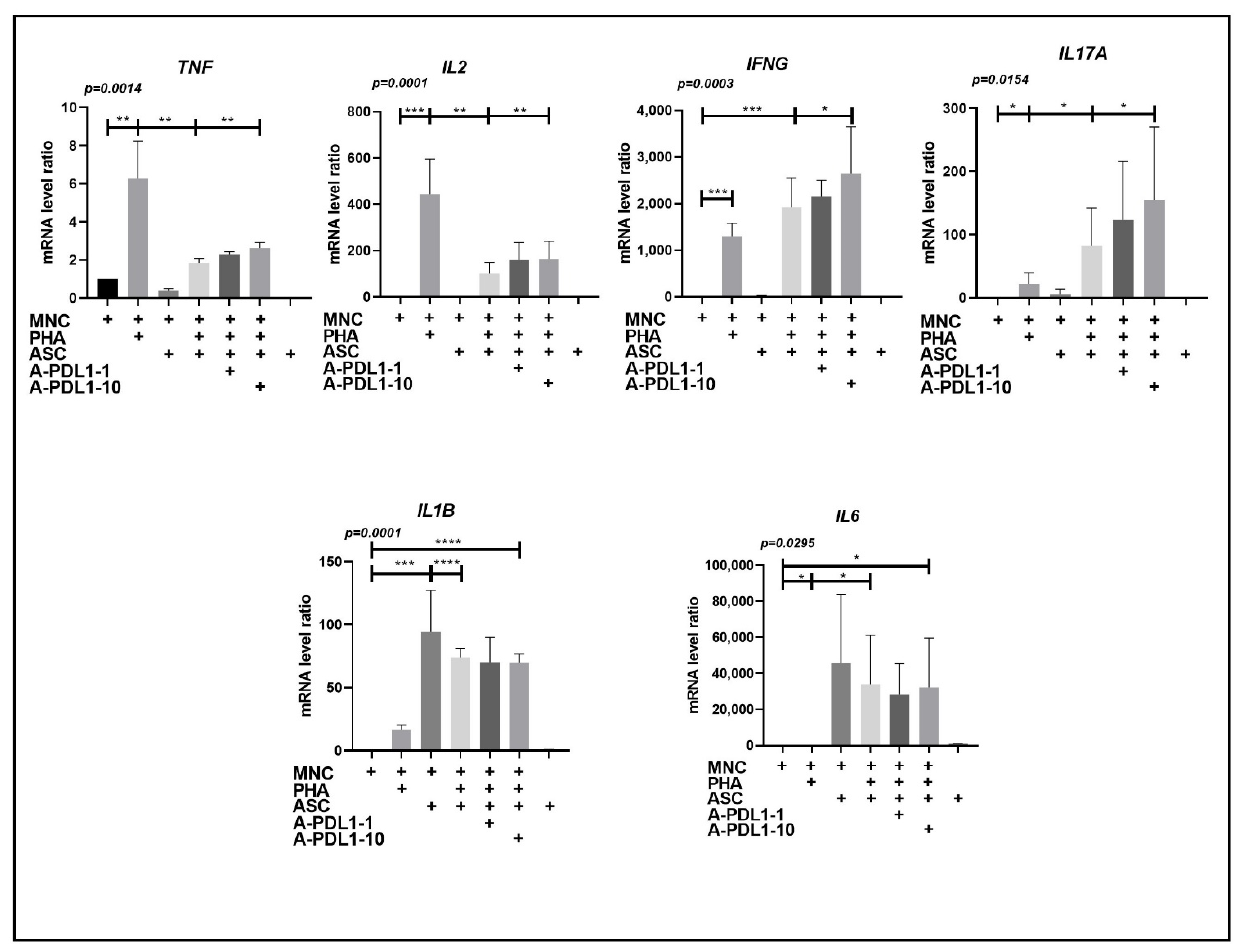
Figure 4. PD-L1 blockade partially restores Th1 cell secretion and improves ob-ASC mediated Th17 cell activation without any effect on pro-inflammatory cytokine secretion by accessory cells. MNC were activated by PHA in the presence or absence of ob-ASC and anti-PD-L1mAbs at concentrations of 1 or 10 µg/mL. Cytokine mRNA expression levels were measured by RT-qPCR. Results were expressed as a ratio relative to the TBP housekeeping gene. The one-way ANOVA with Fisher’s LSD comparison tests were used. Data are the mean ± SD of n = 4. The p -value shown in the figure is from an ANOVA test, whereas ****, ***, **, or * represents p -values of <0.0001, <0.001, <0.01, <0.05 respectively, from Fisher’s LSD tests.